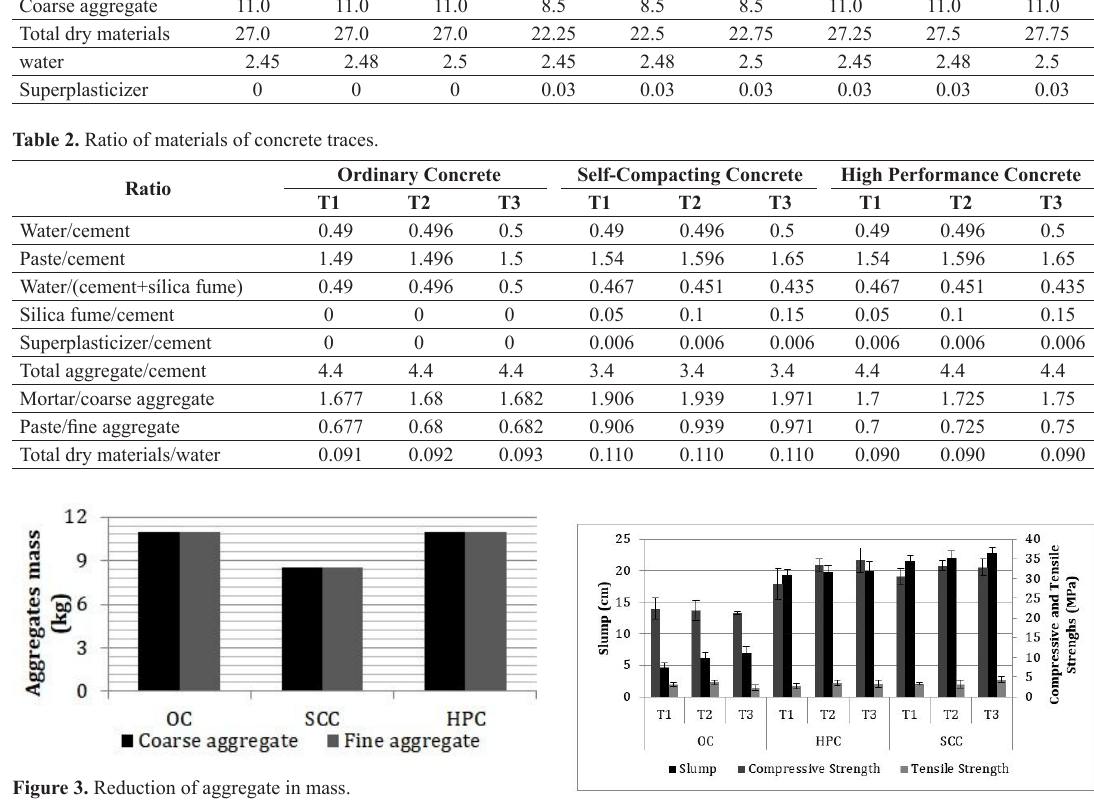
Figure 5. Comparative among slump and hardened concrete strengths.